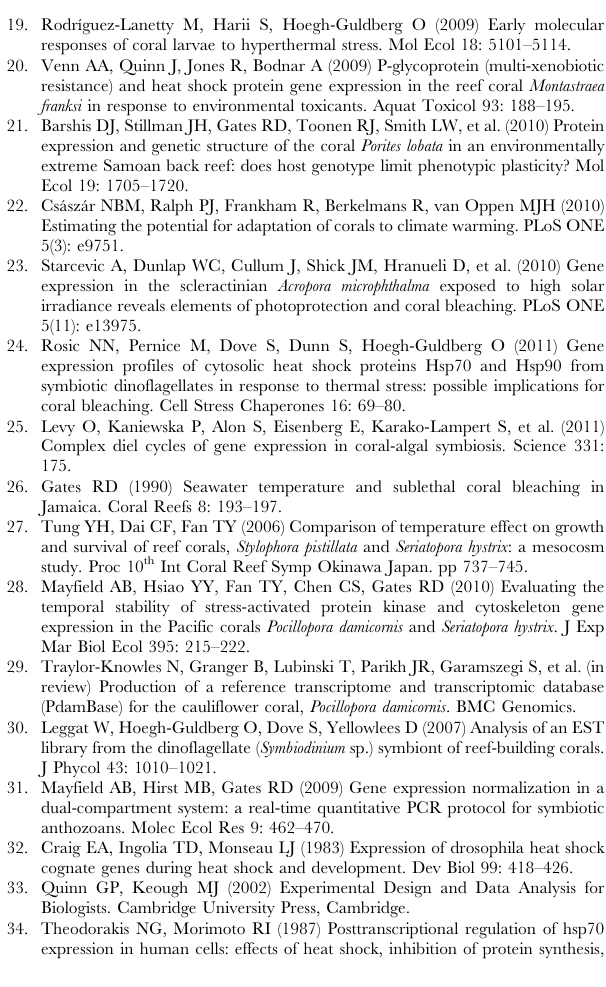
Table S1 Selected Seriatopora hystrix clones spanning 19 functional categories. When multiple clones encoding the